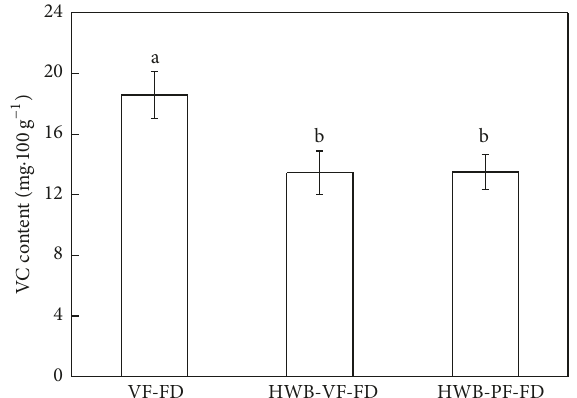
Figure 5: Vitamin C content of freeze-dried samples in 3 freeze- drying methods. VF-FD: apple samples without hot-water pre- treatment were performed with vacuum freezing treatment and freeze-drying process; HWB-VF-FD: apple samples with hot-water pretreatment were performed with vacuum freezing treatment and freeze-drying process; HWB-PF-FD: apple samples with hot- water pretreatment were performed with plate freezing treatment and freeze-drying process. Note . Different letters on the same bar indicate significant differences at 𝑝 = 0.05 by Tukey’s HSD